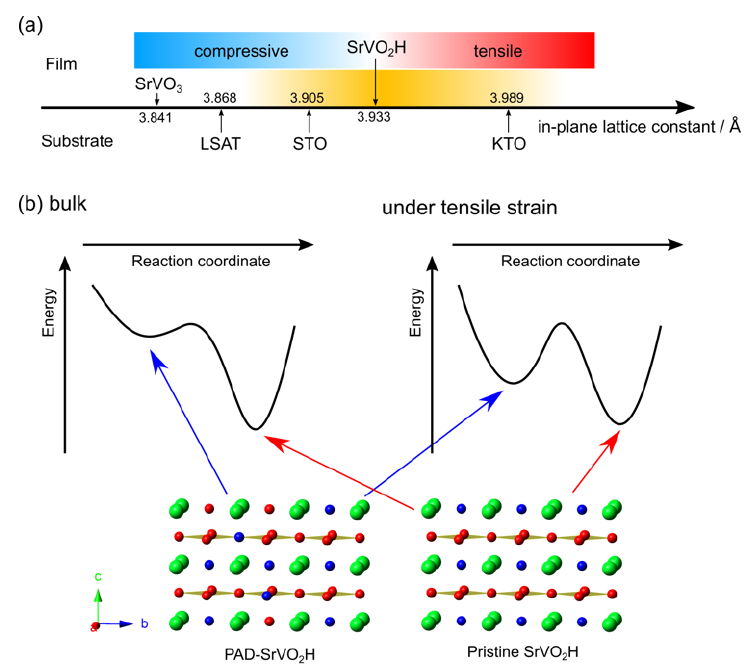
Figure 4. ( a ) In-plane lattice constants of SrVO 3 , SrVO 2 H and substrates. The orange area shows the range where SrVO 2 H can be synthesized. ( b ) Energy diagrams with respect to the reaction coordinate for the reaction from (left) bulk SrVO 3 and (right) SrVO 3 thin film under tensile strain. Partially anion disordered (PAD) SrVO 2 H is a kinetically trapped transient state observed when tensile strain is applied (after 12 h reaction at 530 °C). A longer reaction (24 h) transforms this intermediate state to SrVO 2 H with complete anion order.